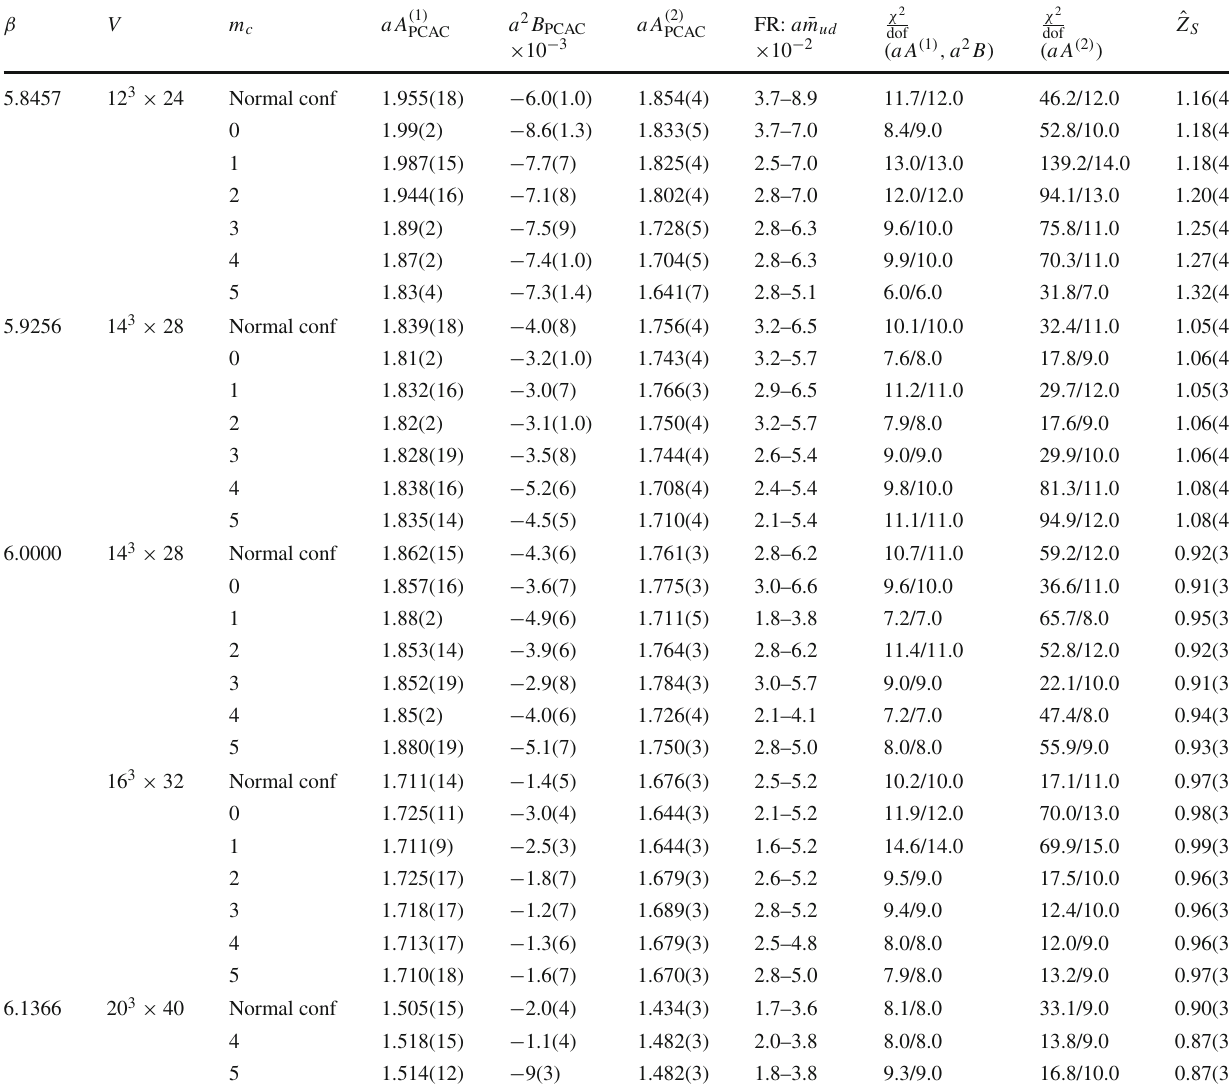
( 2 ) , aA and intercept a 2 B PCAC by the functions ( am π ) 2 = a 2 A PCAC PCAC